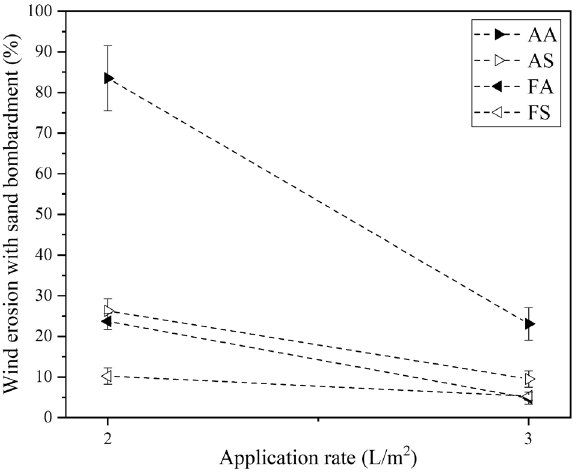
Figure 11. Wind erosion after sand bombardment versus application rate.